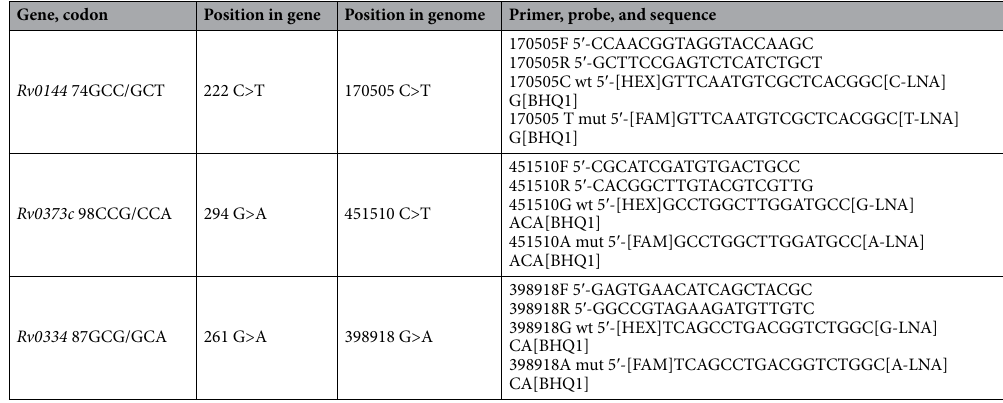
Table 1. Oligonucleotides primers and labeled probes used for detection of three synonymous SNPs specific of the Beijing 1071-32-cluster. wt, wild type; mut, mutant; LNA, locked nucleic